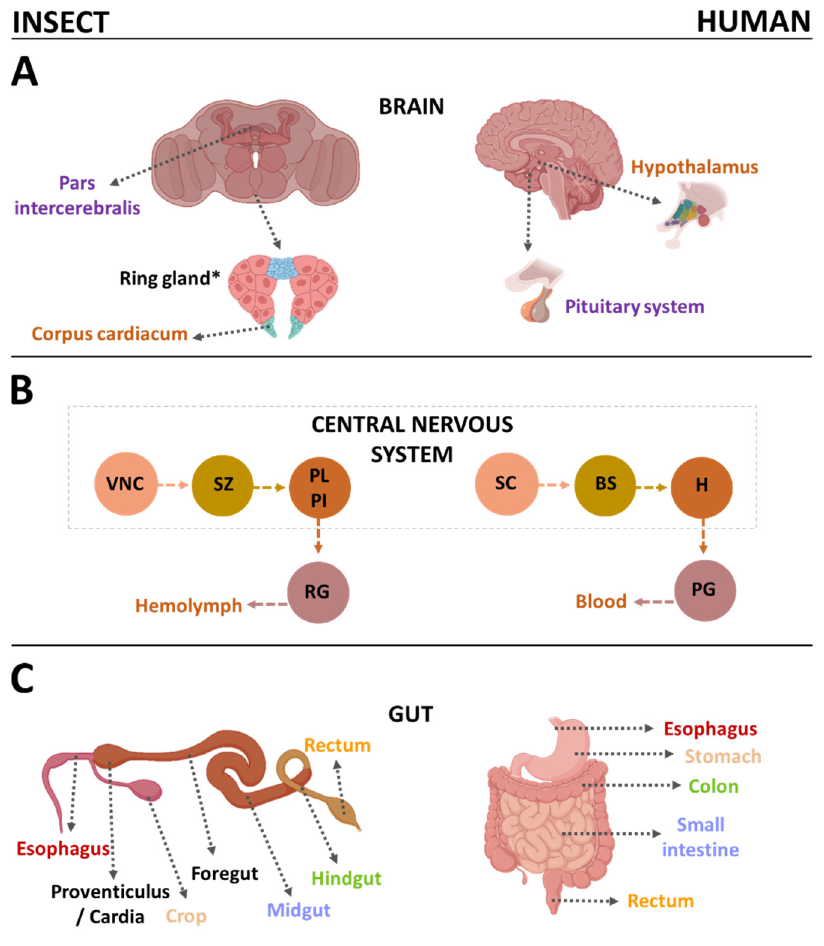
Figure 1. ( A ) Comparison of insect and human brains to show equivalent structures. ( B ) Endocrine pathway in insects and humans (VNC—ventral nerve cord; SZ—subesophageal zone; PI—pars intercerebralis; PL—pars lateralis; RG—ring gland; SC—spinal cord; BS—brainstem; H—hypothalamus; PG—pituitary gland). ( C ) Comparison of insect and human guts to show similar structures. The same colored text represents equivalent organs in insects and humans. * The ring gland is found only in some Dipterans e.g., Drosophila.